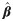
Scenario II. Coefficient of determination (R2) and root mean square error (RMSE) resulting from the solution of the linear regression problem with least-squares for the recovery rate (β^).